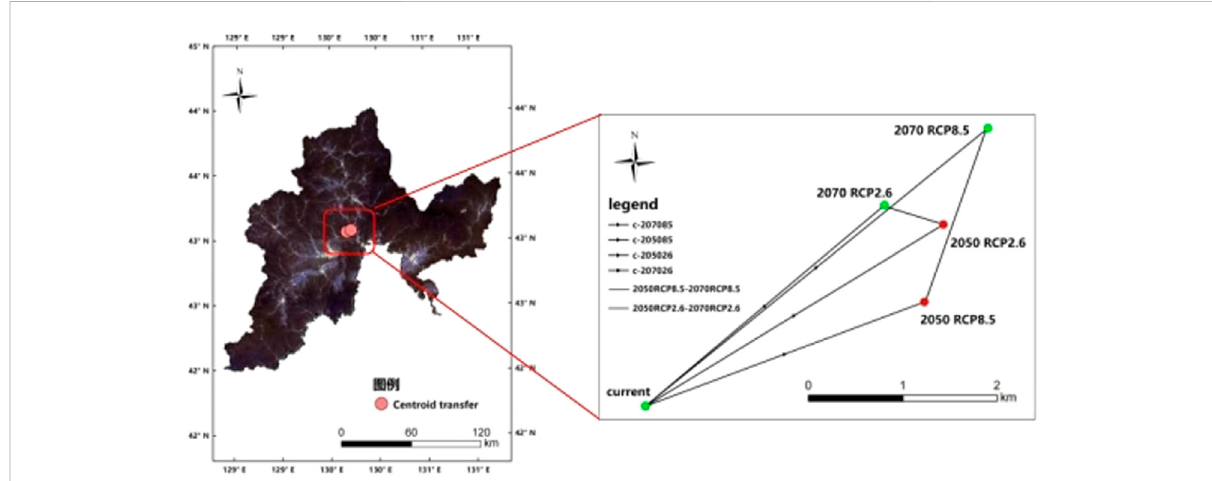
FIGURE 7 Variation in suitable areas of Deyeuxia angustifolia in the Tumen River Basin.